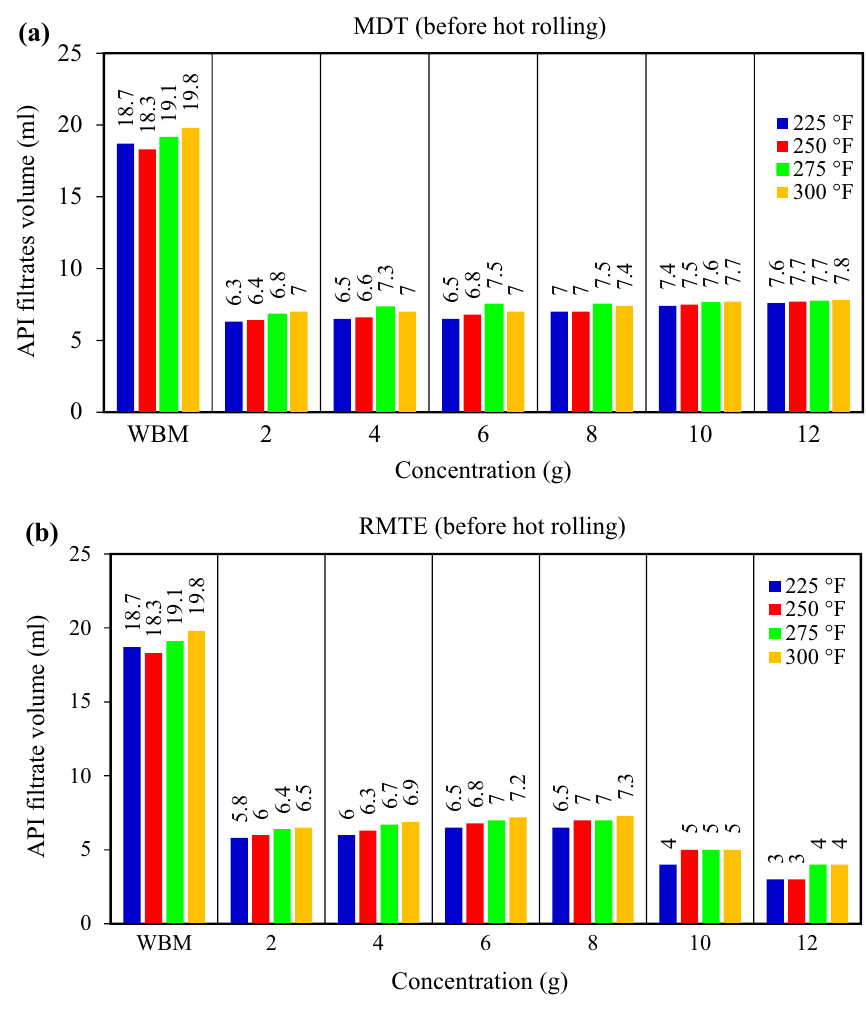
Fig. 10 API filtrate volume of a MDT and b RMTE mud